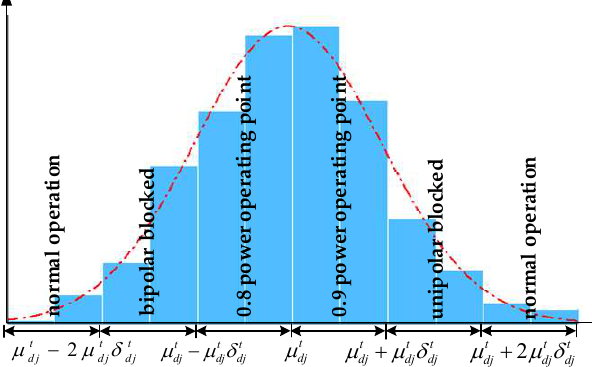
Figure 2. Simulation for the state of the non-maintenance lines and DC transmission lines. Table 2. Information of the transformer to be maintained.